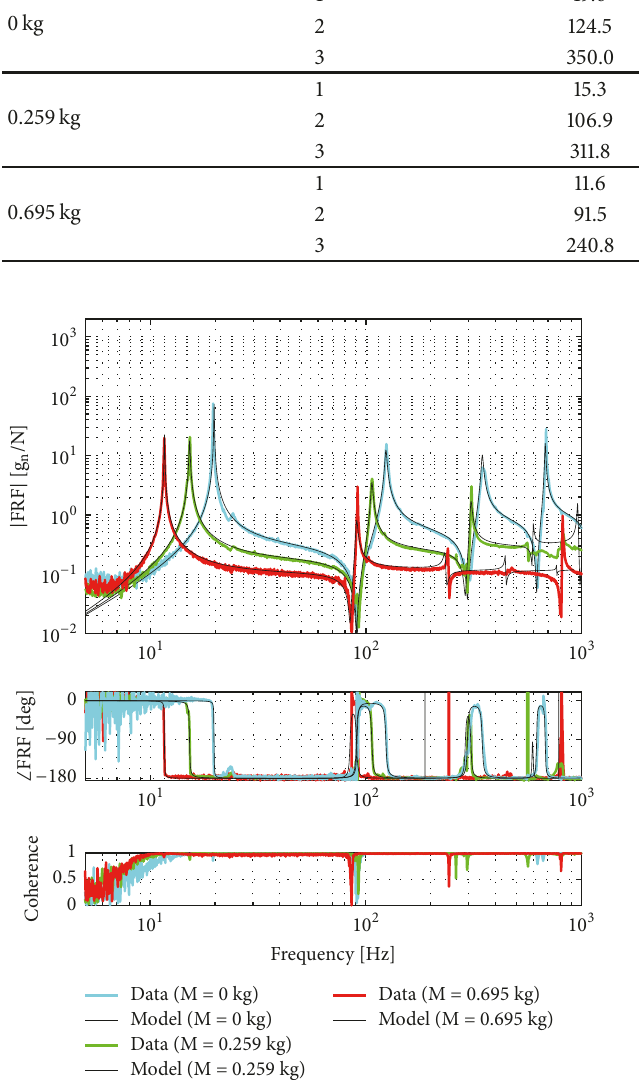
Figure 2: Frequency response functions (FRFs) for the bare beam ( 𝑀 = 0kg), beam with the electromagnet( 𝑀 = 0.259kg), and beam with the electromagnetand added mass plates ( 𝑀 = 0.695kg). Data isfrom thetip accelerometerand modal hammerimpactsat483 mm (19 in) from the base. Note that 𝑔 𝑛 = 9.81 m ⋅ s −2 .